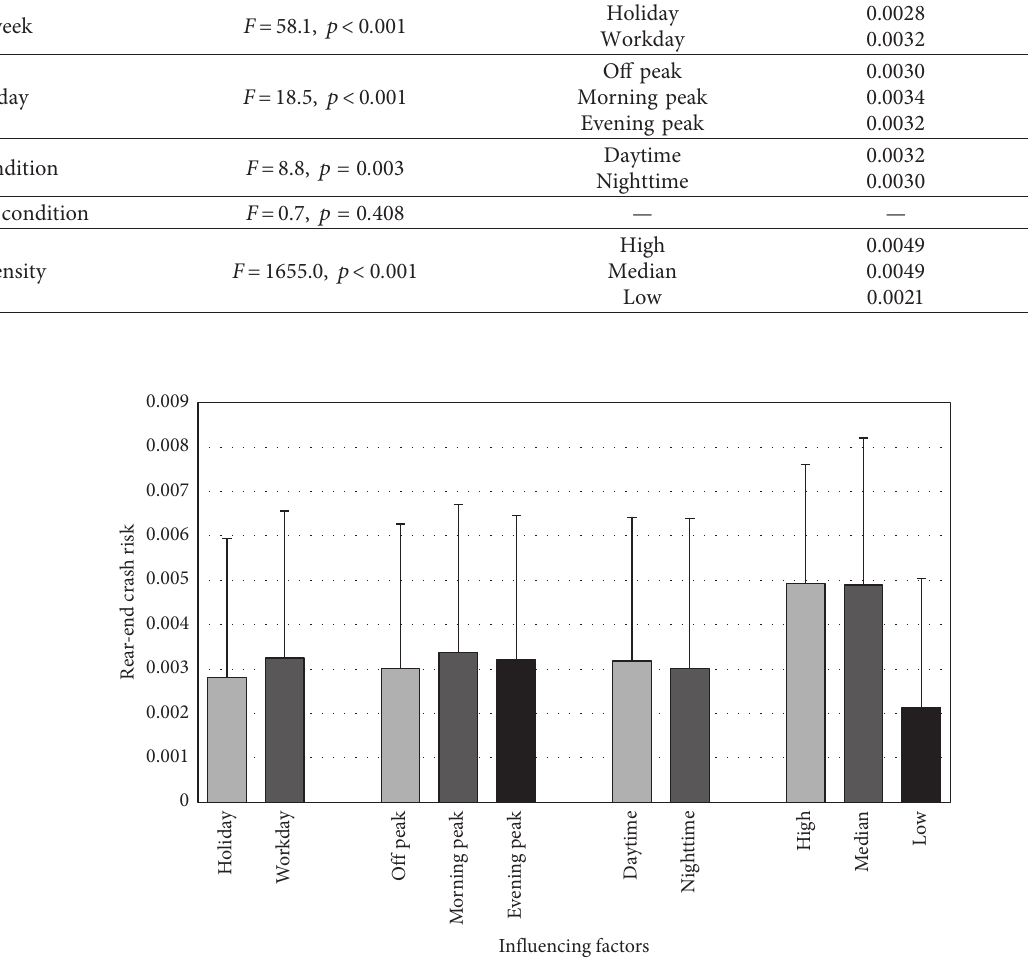
Figure 6: Rear-end crash risk under different influencing